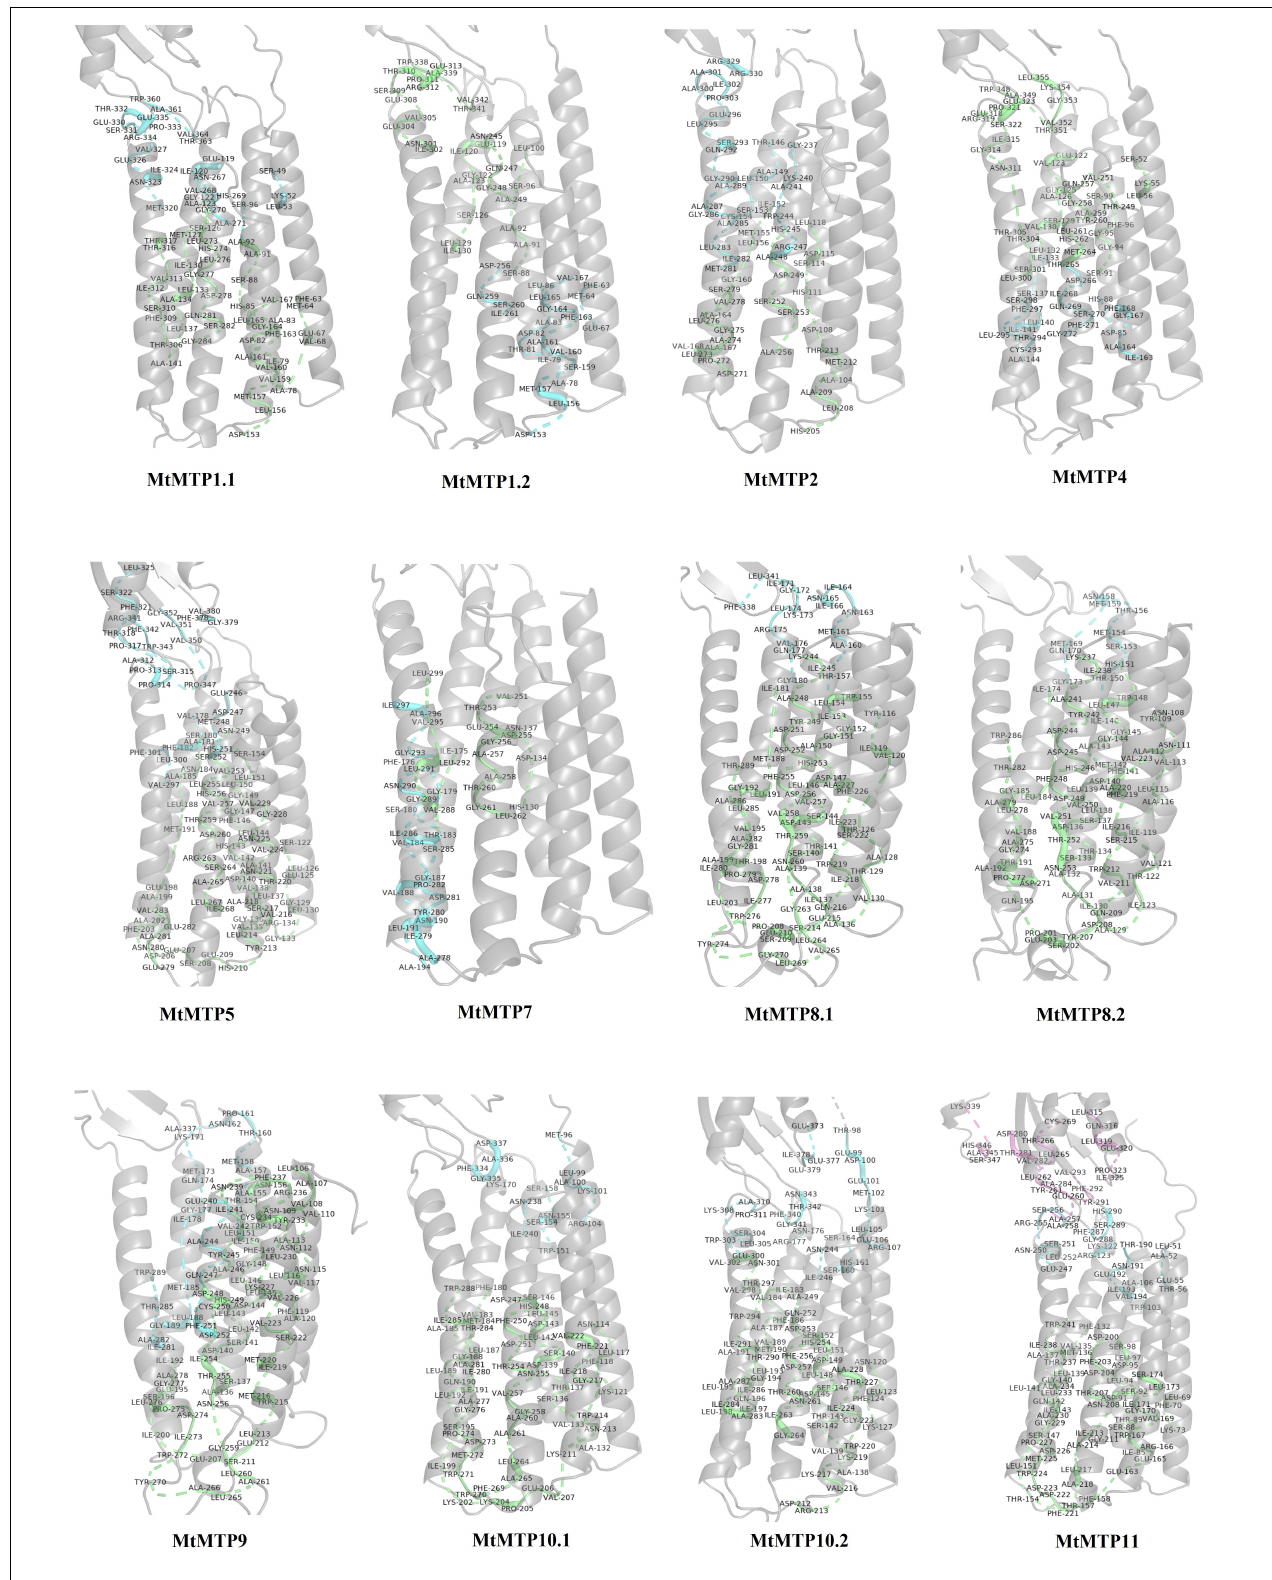
FIGURE 5 | Docking analysis of pocket sites of MTP proteins in M. truncatula .